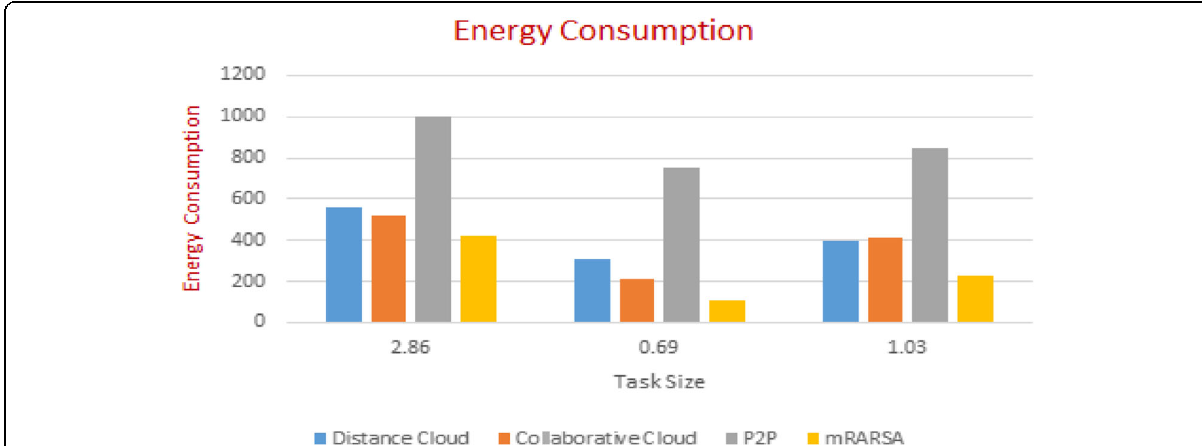
Fig. 10 Energy consumption performance evaluation graph. This graph represents the energy consumption performance against the utilization of the running cloud resources for first resource demanding text scanner (OCR) application